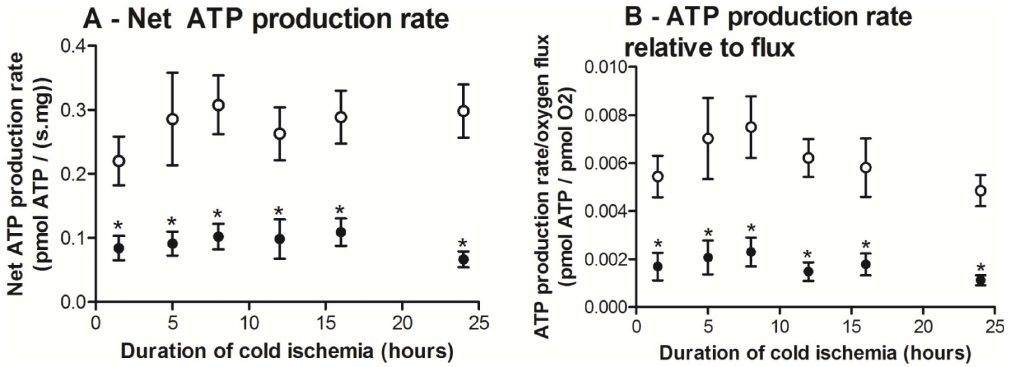
Figure 5. Net adenosine triphosphate (ATP) production rate and ATP production rate relative to flux of ob/ob and lean livers following different duration of cold ischemia (hours). Ob/ob livers showed significantly lower net ATP production (A) and ATP production rate relative to flux (B) at all time points. Data are shown as mean 6 SEM (n=6 mice/group; ob/ob livers, closed circle; lean livers, open circle). Analyses were performed using two-way ANOVA. *, P , 0.05 (vs. lean).